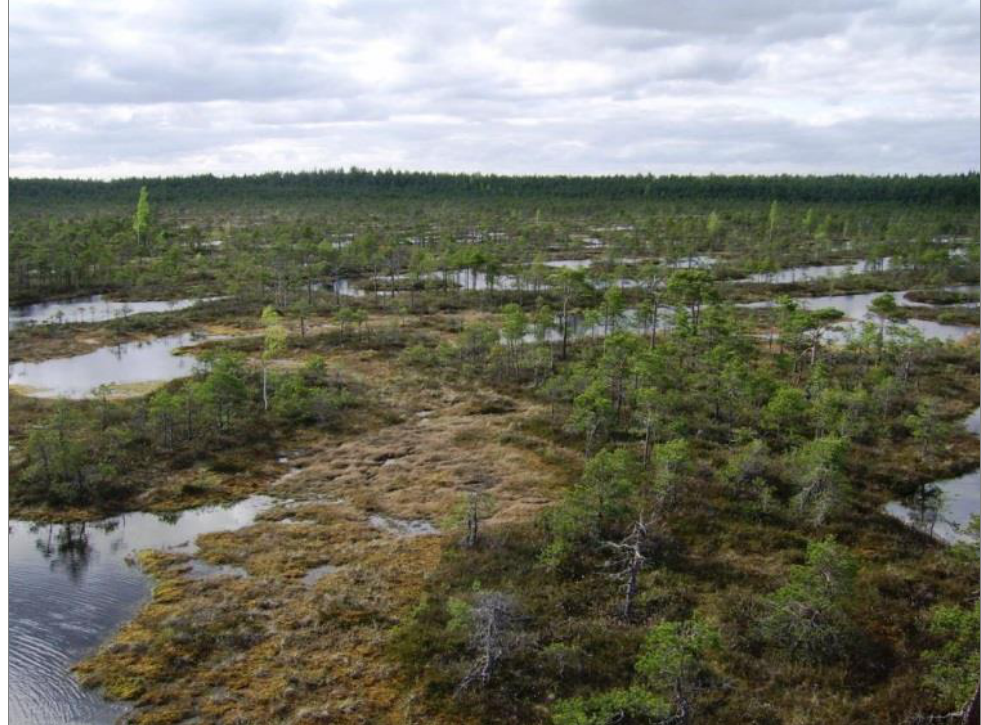
Figure 3. North–south oriented and sparsely wooded ridge-pool ecotope on Männikjärve Bog (GW well site Mä211), March 2012. Photo: E.